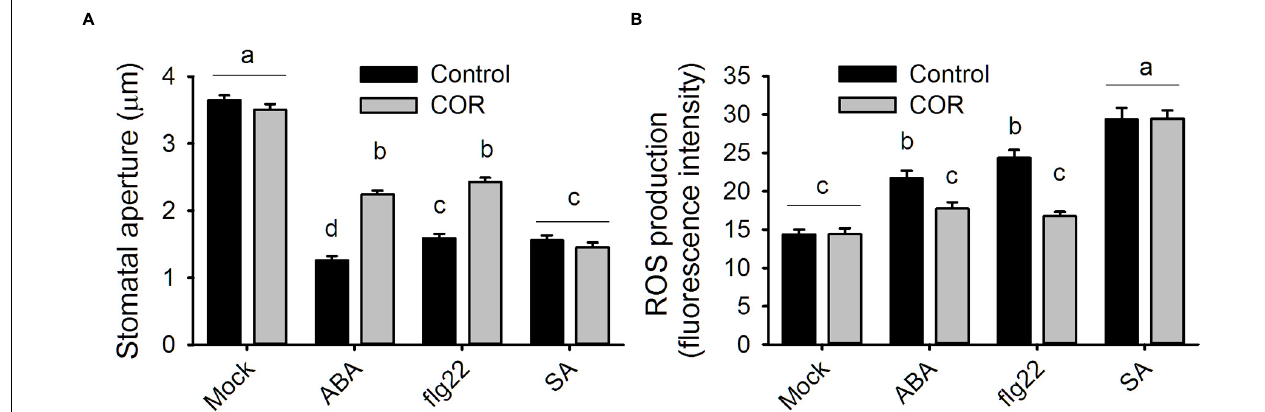
FIGURE 1 | Coronatine affects stomatal closure and ROS production by ABA and flg22 but not by SA. (A) Coronatine (COR, 1.56 µ M) inhibited stomatal closure in response to ABA (20 µ M) or flg22 (5 µ M) but not to SA (10 µ M). Stomatal apertures were measured 1.5 h after application of the respective treatments. (B) Coronatine (COR, 1.56 µ M) inhibited guard cell ROS production in response to ABA (20 µ M) or flg22 (5 µ M) but not to SA (10 µ M). ROS were detected as H 2 DCFDA fluorescence in guard cells 20 min after treatment. In both experiments coronatine was added 10 min before other treatments. Different letters indicate significant differences at p < 0.05 in (A,B ; one-way ANOVA, Tukey’s test). Error bars represent SE from two (B) to three (A) independent trials, n = 40 per trial in all experiments.